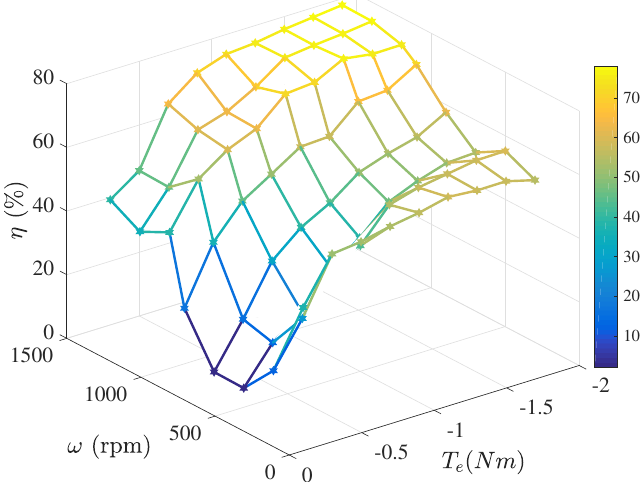
Figure 16. Experimental efficiency of the SRG-based